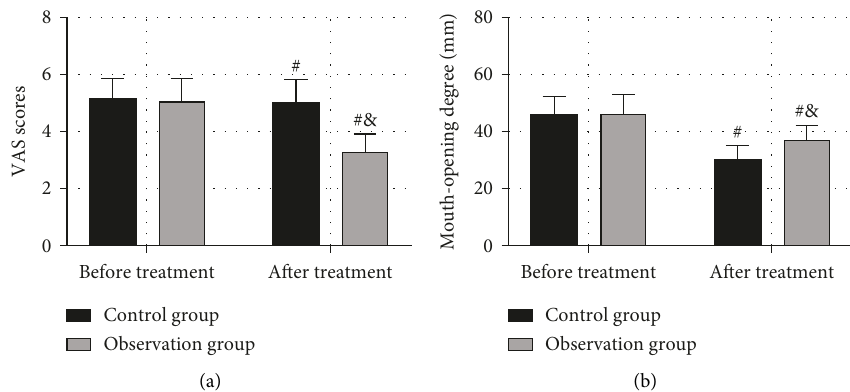
Figure 2: Comparison of pain and mouth opening. (a) Comparison of VAS score. (b) Comparison of mouth-opening degree. Note. # indicates that the difference is statistically significant compared with that before treatment ( P < 0 . 05), and & indicates that the difference is statistically significant compared with the control group ( P < 0 . 05).